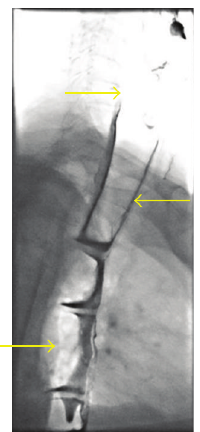
to 33 cms, which fully resolved the posterior pharyngeal wall swelling with correction of the airway compromise.